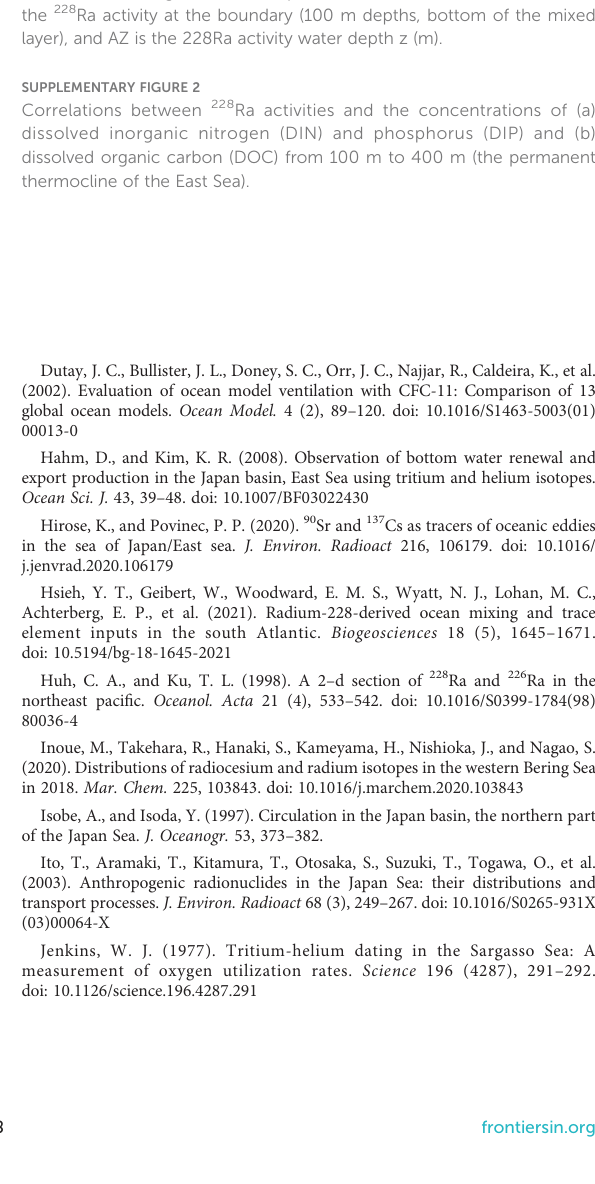
SUPPLEMENTARY FIGURE 1 ln(A0/AZ) values against water depth (m) at the EC1 station, where A0 is the 228 Ra activity at the boundary (100 m depths, bottom of the mixed layer), and AZ is the 228Ra activity water depth z (m). SUPPLEMENTARY FIGURE 2 Correlations between 228 Ra activities and the concentrations of (a) dissolved inorganic nitrogen (DIN) and phosphorus (DIP) and (b) dissolved organic carbon (DOC) from 100 m to 400 m (the permanent thermocline of the East